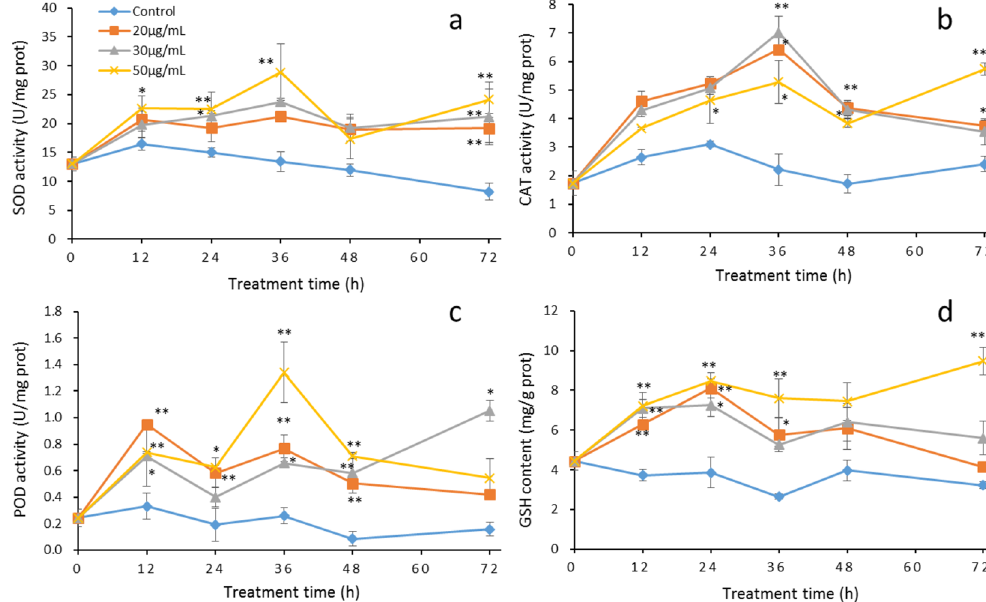
Figure 7. The response of the antioxidant system of M. aeruginosa to PG. Algal cells treated with 20 µ g/mL, 30 µ g/mL or 50 µ g/mL of PG were harvested for activity analyses of SOD ( a ), CAT ( b ), POD ( c ), and GSH ( d ). Values are means ± SD (n = 3). * ( p < 0.05) and ** ( p < 0.01) represent significant differences compared to the control